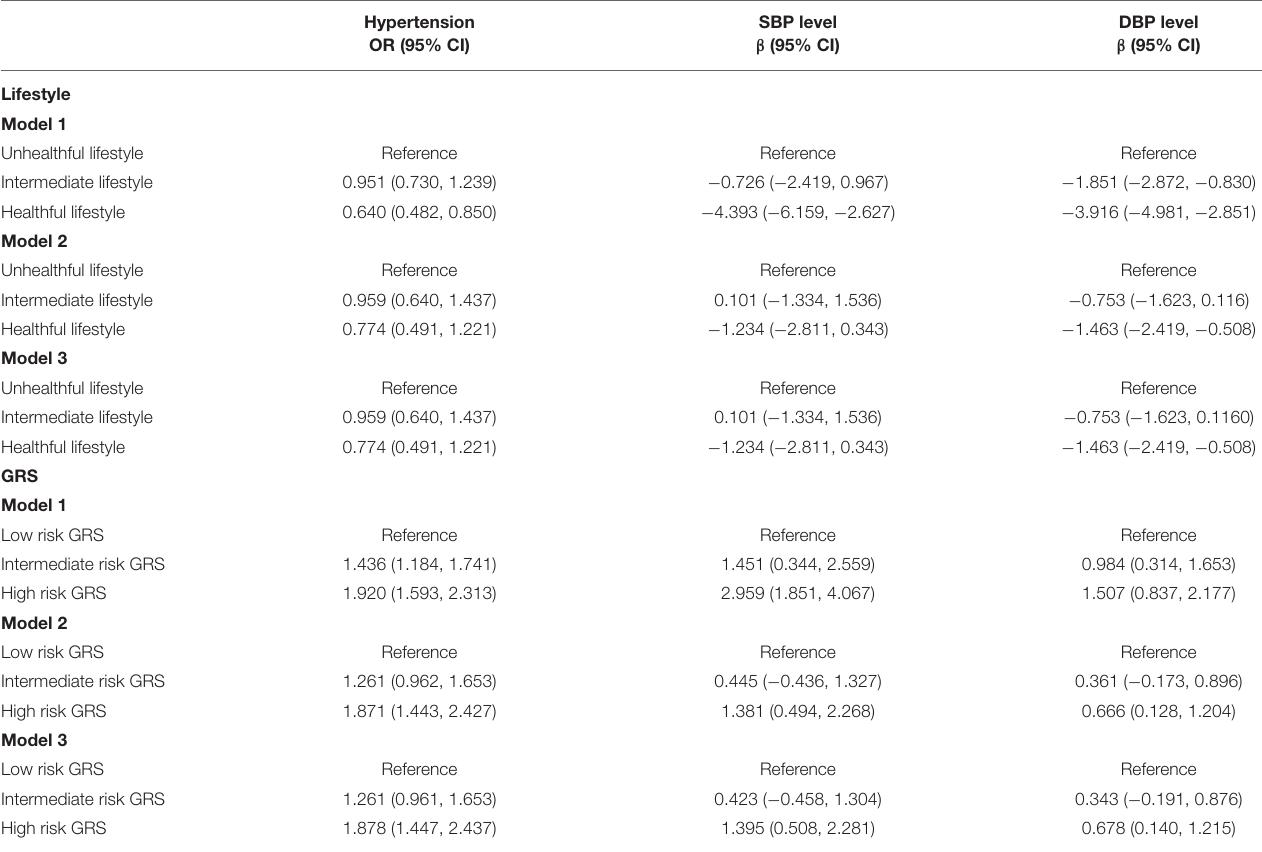
TABLE 2 | Association of lifestyle and genetic risk score (GRS) with 3-year risk of hypertension and evaluated blood pressure.